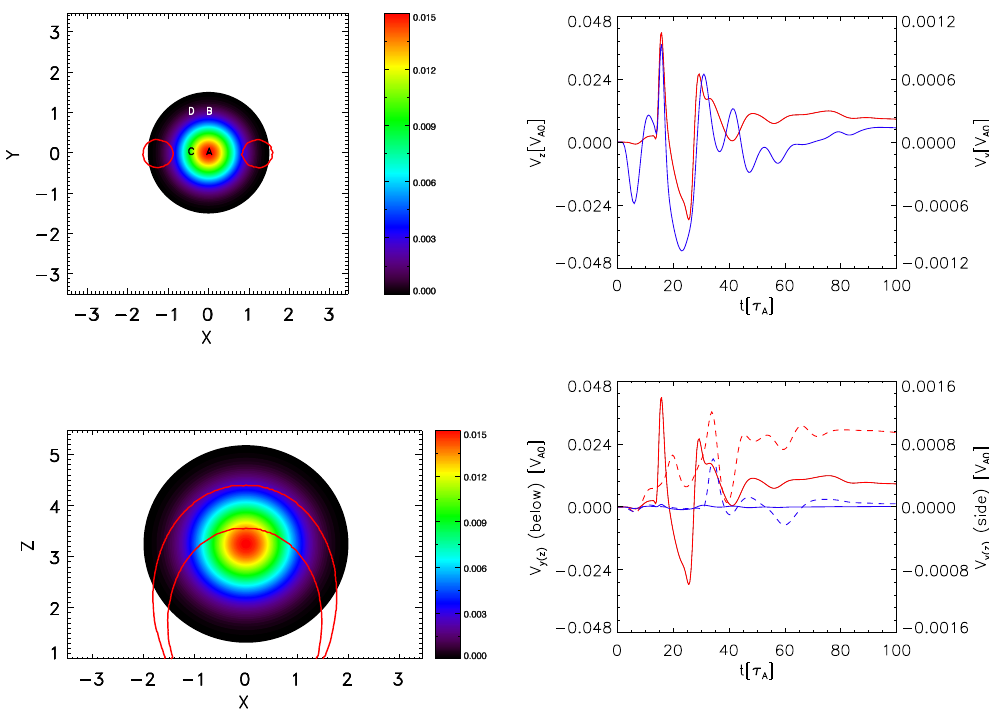
Fig. 2. Left panels: Spatial profiles of the pulses launched in z component of velocity (top panel, xy plane) and in y component of velocity (bottom panel, xz plane) (color scales). Red contours display the initial position of the loop (different plane than the pulse in bottom panel). Letters in a top panel show various positions of the center of the pulse. Spatial coordinates are given in units of L s . Right panels: Time signatures of z ( y ) component of velocity at the loop apex (red (blue) lines, respectively). Top panel corresponds to the excitation by the pulse shown in top panel of this figure (note difference in scales for V z and V y ). Bottom panel corresponds to the excitation by the pulse shown in top panel (solid lines) and by the pulse shown in bottom panel of this (cid:2)gure (dashed lines), respectively. Note difference in V z : V y ratio for both kinds of excitation.